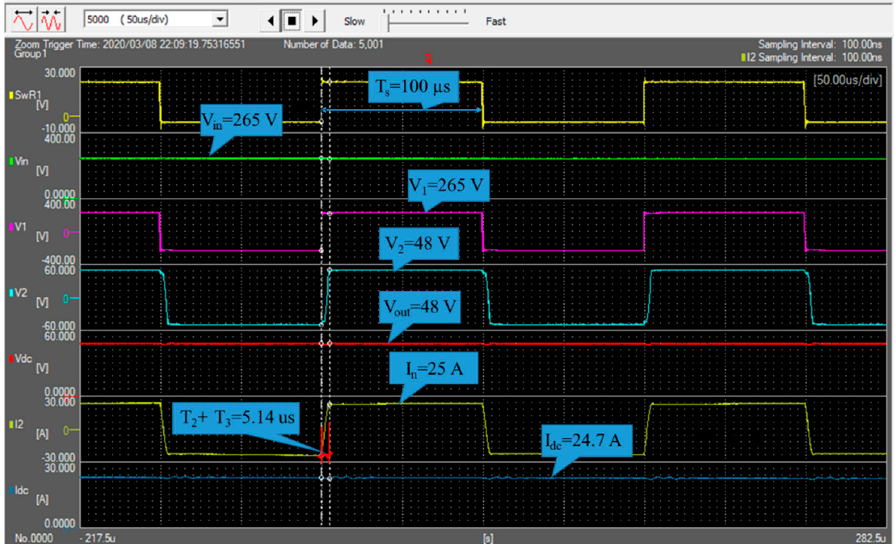
Figure 12. Experimental voltage and current waveforms at f s = 5 kHz. With all the experimental voltage and current waveforms, no high peak stress on the primary and secondary sides is observed as it is in some cases of the normal LC resonant circuit. The overshoot values of primary and secondary voltage in all cases are within the range of 5~10 percent, which is normal, and which is in fact another advantage of this topology because switching devices and capacitors can be selected that are small enough to reduce the overall